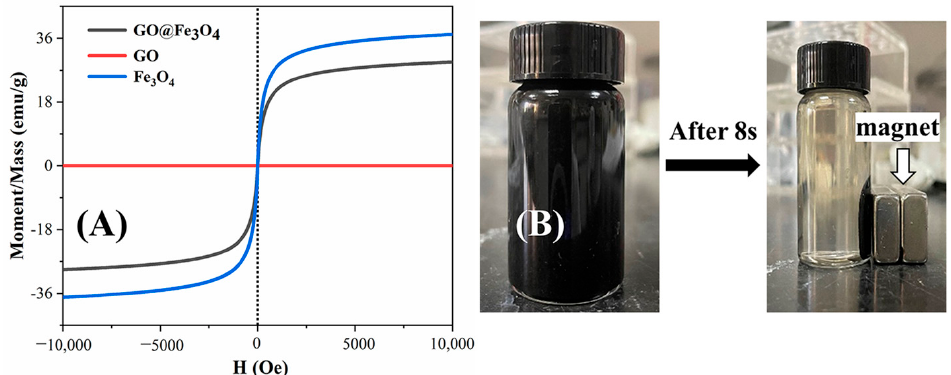
Figure 6. ( A ) Magnetization curves of GO, Fe 3 O 4 , and GO@Fe 3 O 4 at 300 K. ( B ) Real image of magnet separation of the GO@Fe 3 O 4 nanocomposites.